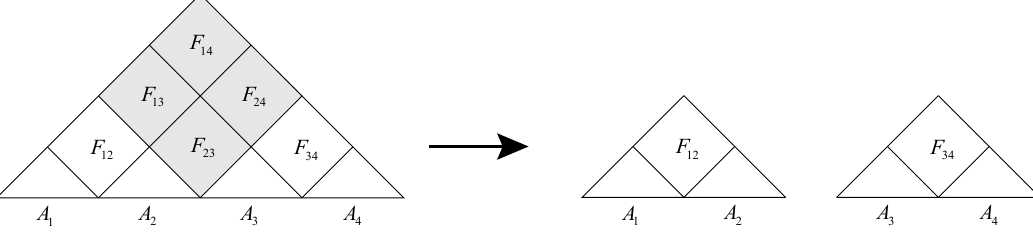
Figure 13 . Taking off the corresponding “external threads” entanglement corresponds to the removal of a diamond-like region in the kinematic space, and the original kinematic space was separated into two disconnected new kinematic